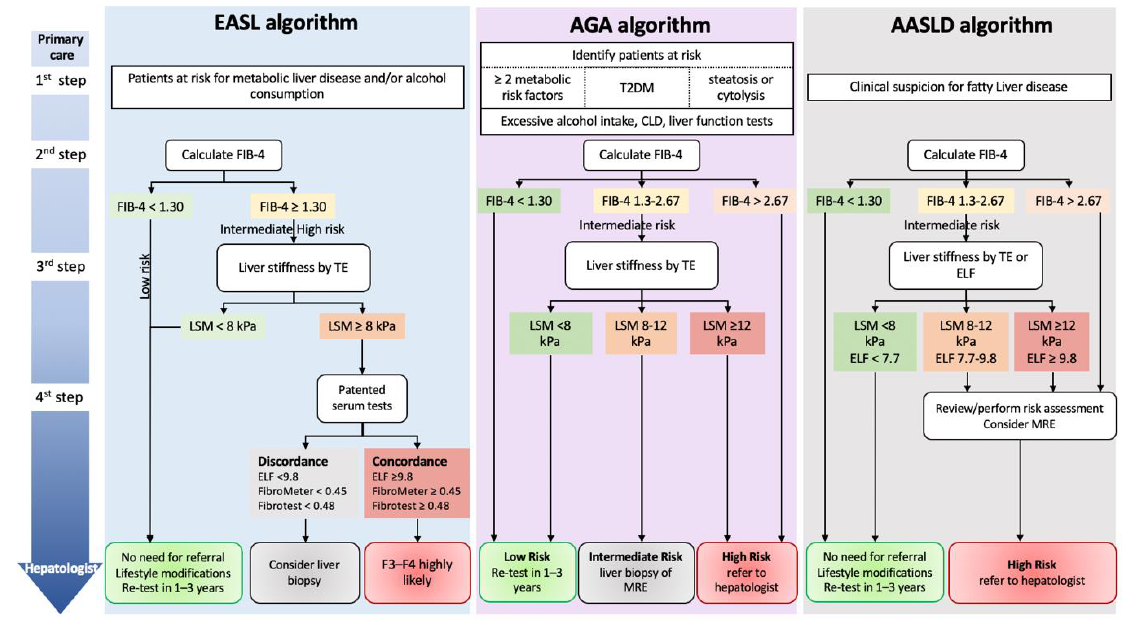
Figure 1. Referral pathway proposed by the European Association for the Study of the Liver (EASL), the American Gastroenterology Association (AGA), and the American Association for the Study of Liver Disease (AASLD) to noninvasively assess advanced liver fibrosis. Modified from [11,45]. CLD: chronic liver disease; ELF: enhanced liver fibrosis; LSM: liver stiffness measurement; MRE: magnetic resonance elastography; T2DM: type 2 diabetes mellitus, TE: transient elastography.